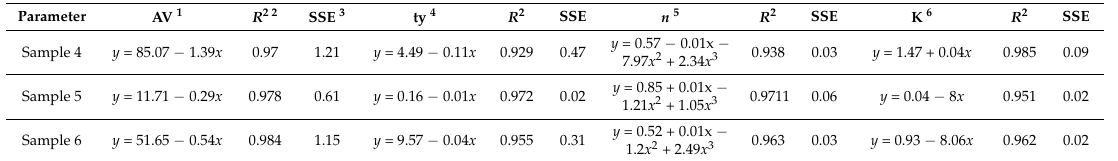
Table 6. Rheological properties with temperature characteristic equations of the SFPDF containing GC.